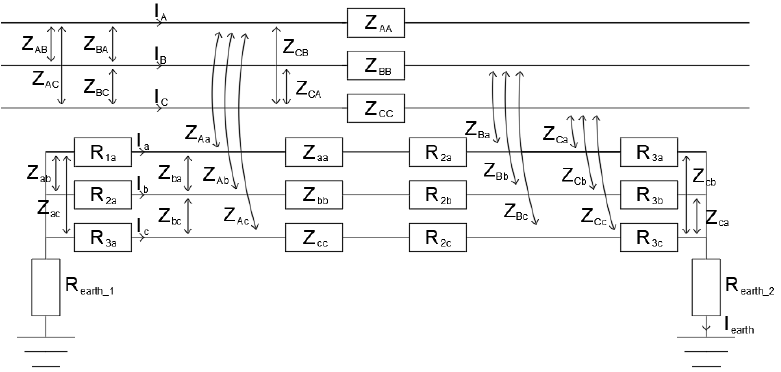
Figure 1 . Factors affecting screen current flow under load conditions, where: Z—impedance, R— resistance, A, B, C—cable cores, a, b, c—cable screens, 1—cable beginning, 2—cable joint, 3—cable end.